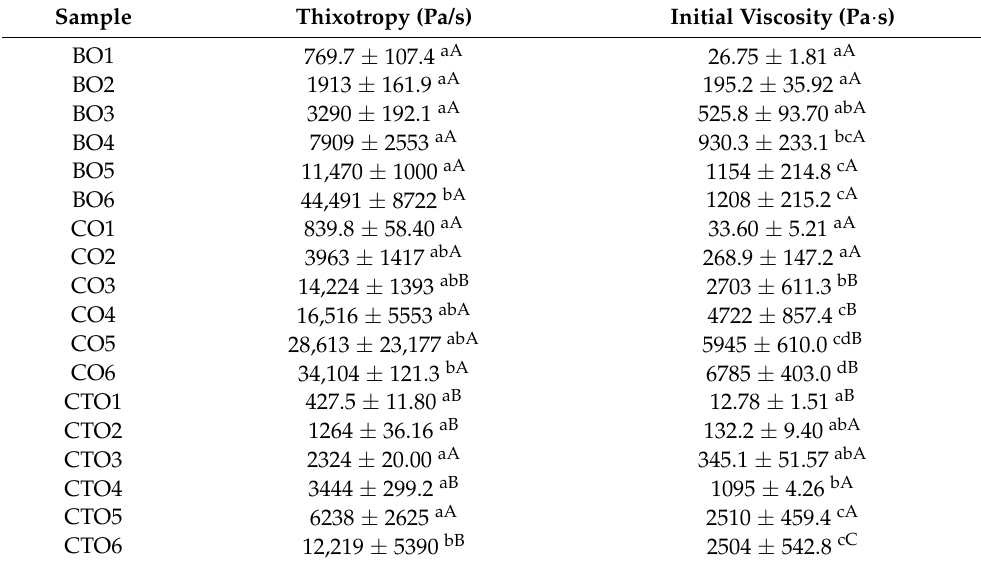
Table 1. Thixotropy and initial viscosity of all organogel samples. Different small letters indicate statistically significant differences between different concentrations within the same organogelator, while different capital letters indicate statistically significant differences between different organogels ( p < 0.05).